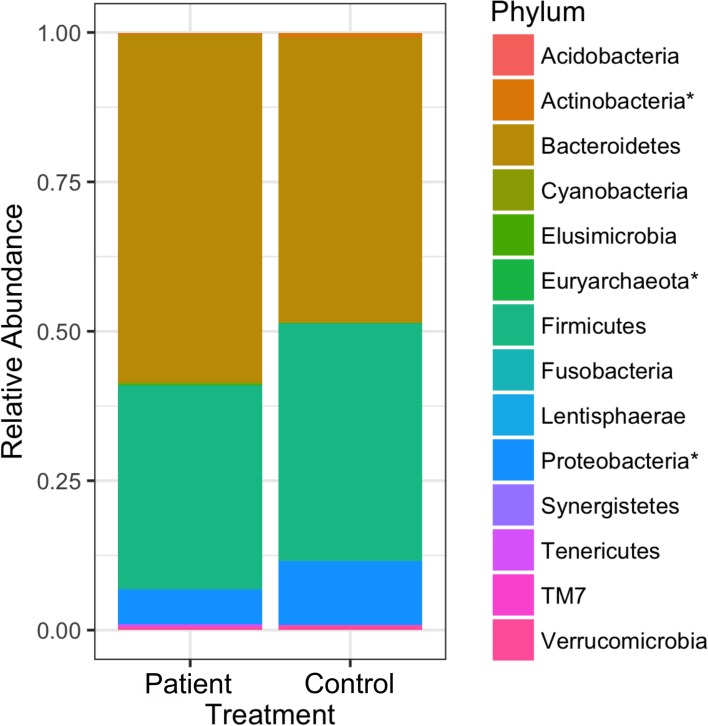
The average relative abundance of phyla found in GSD patients and healthy controls.Phyla followed by an asterisk (*) are different, both in terms of statistics and biological consistency, between patients and controls at p and FDR ≤ 0.05: Euryarchaeota (LDA score = 1.75), Actinobacteria (LDA score = 3.06) and Proteobacteria (LDA score = 3.94). Firmicutes was marginally significantly different with p = 0.064, LDA score = 4.52 and FDR = 0.112.